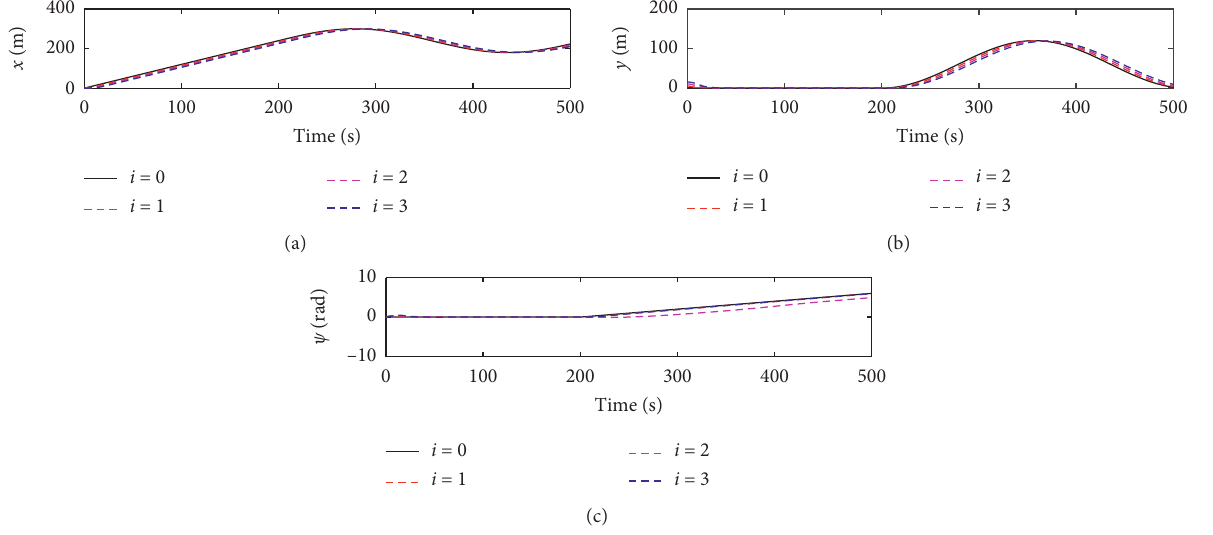
Figure 4: Positions and orientations of the MSVs.